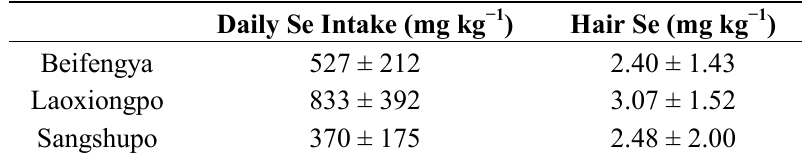
Table 4. Daily Se intake and hair Se content of local residents from the three